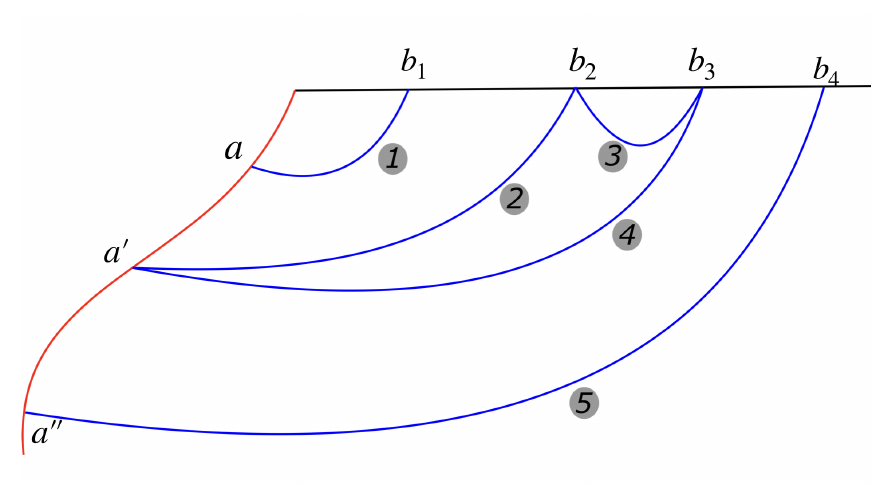
Figure 3: Schematic for the islands proposal-I for the entanglement negativity of the mixed state configuration for disjoint intervals in phase-I. The circled curves denote the backreacted cosmic branes in the double holographic picture of our